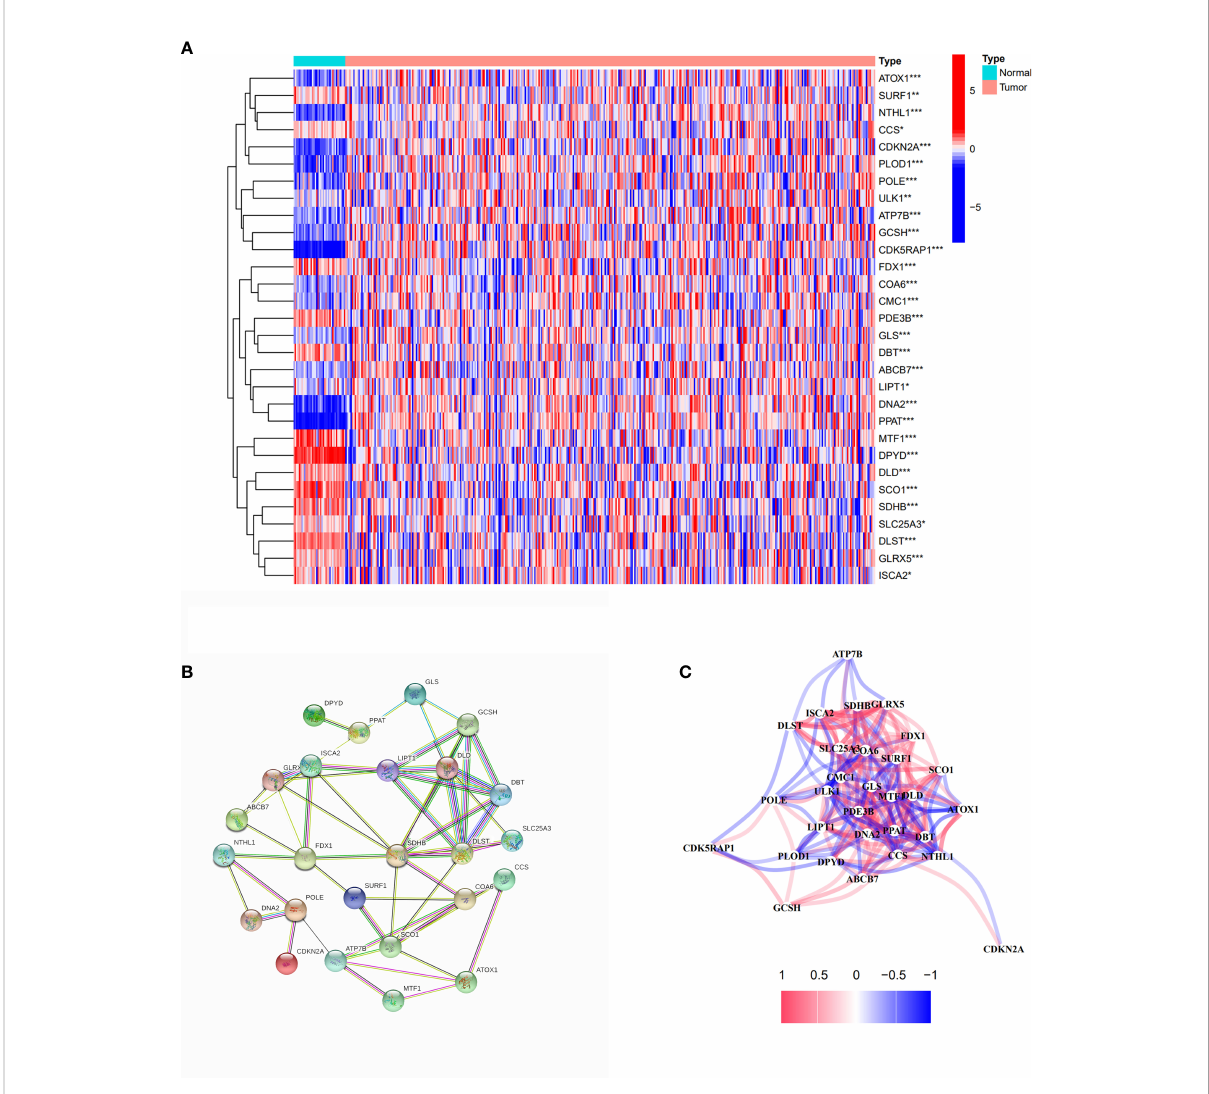
FIGURE 2 Identi fi cation of differentially expressed cuproptosis-related genes. (A) The heatmap of differentially expressed cuproptosis-related genes in COAD compared with normal tissues. Red spots represent upregulated genes; blue spots represent downregulated genes. *p<0.05, **p<0.01, ***p<0.001. (B) PPI network of differentially expressed cuproptosis-related genes. (C) The correlation network of differentially expressed cuproptosis-related